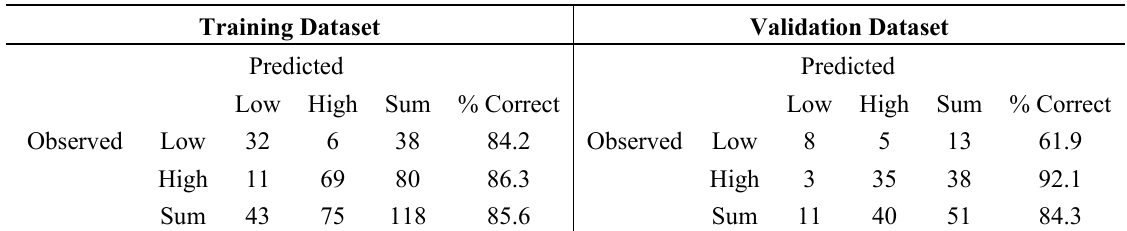
Table 9. Observed and predicted cross-tabulation for both training and validation datasets.